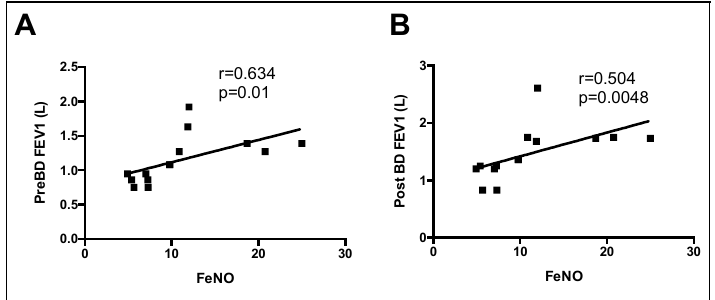
Figure 4. Correlation of the fraction of exhaled nitric oxide (FeNO) with forced expiratory ) ( A ) before (pre); and ( B ) after (post), inhaled bronchodilator volume in one second (FEV 1 (BD). Spearman’s correlation coefficient and p -values are as indicated.